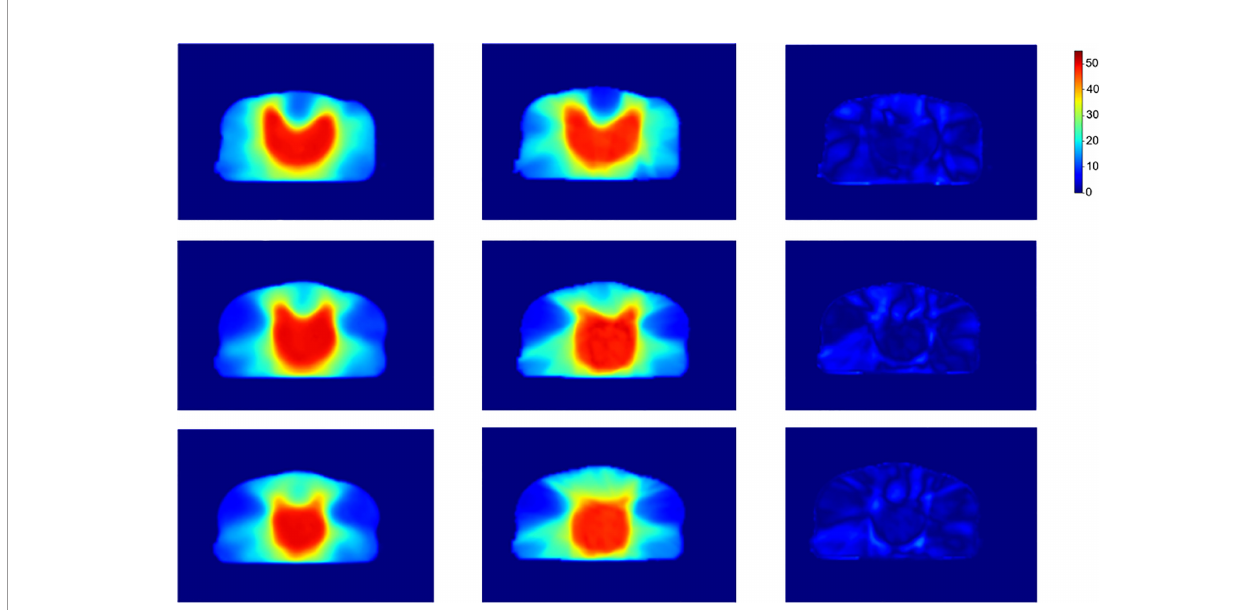
FIGURE 3 | Dose distribution of our proposed method, the ground truth and the corresponding difference. From left to right shows the slices predicted by our method, the corresponding slices of the ground truth, and the dose difference,